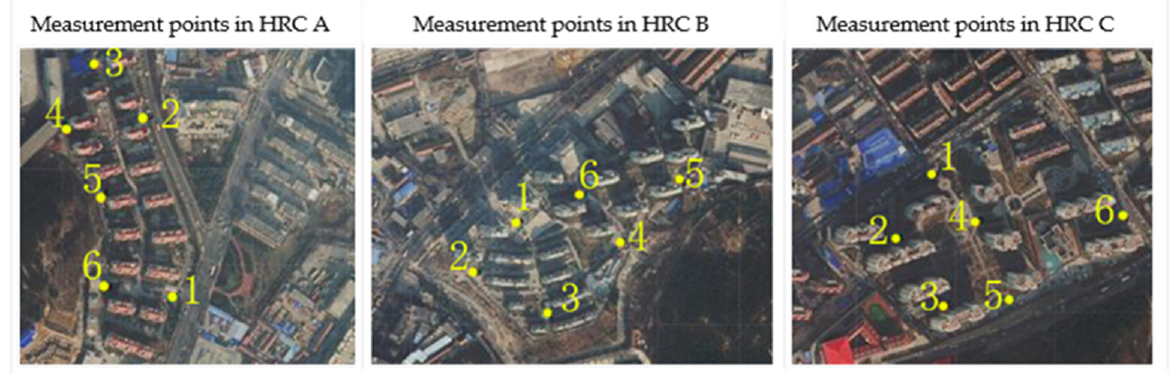
Figure 4. Measurement points (numbered from 1 to 6) in HRCs.